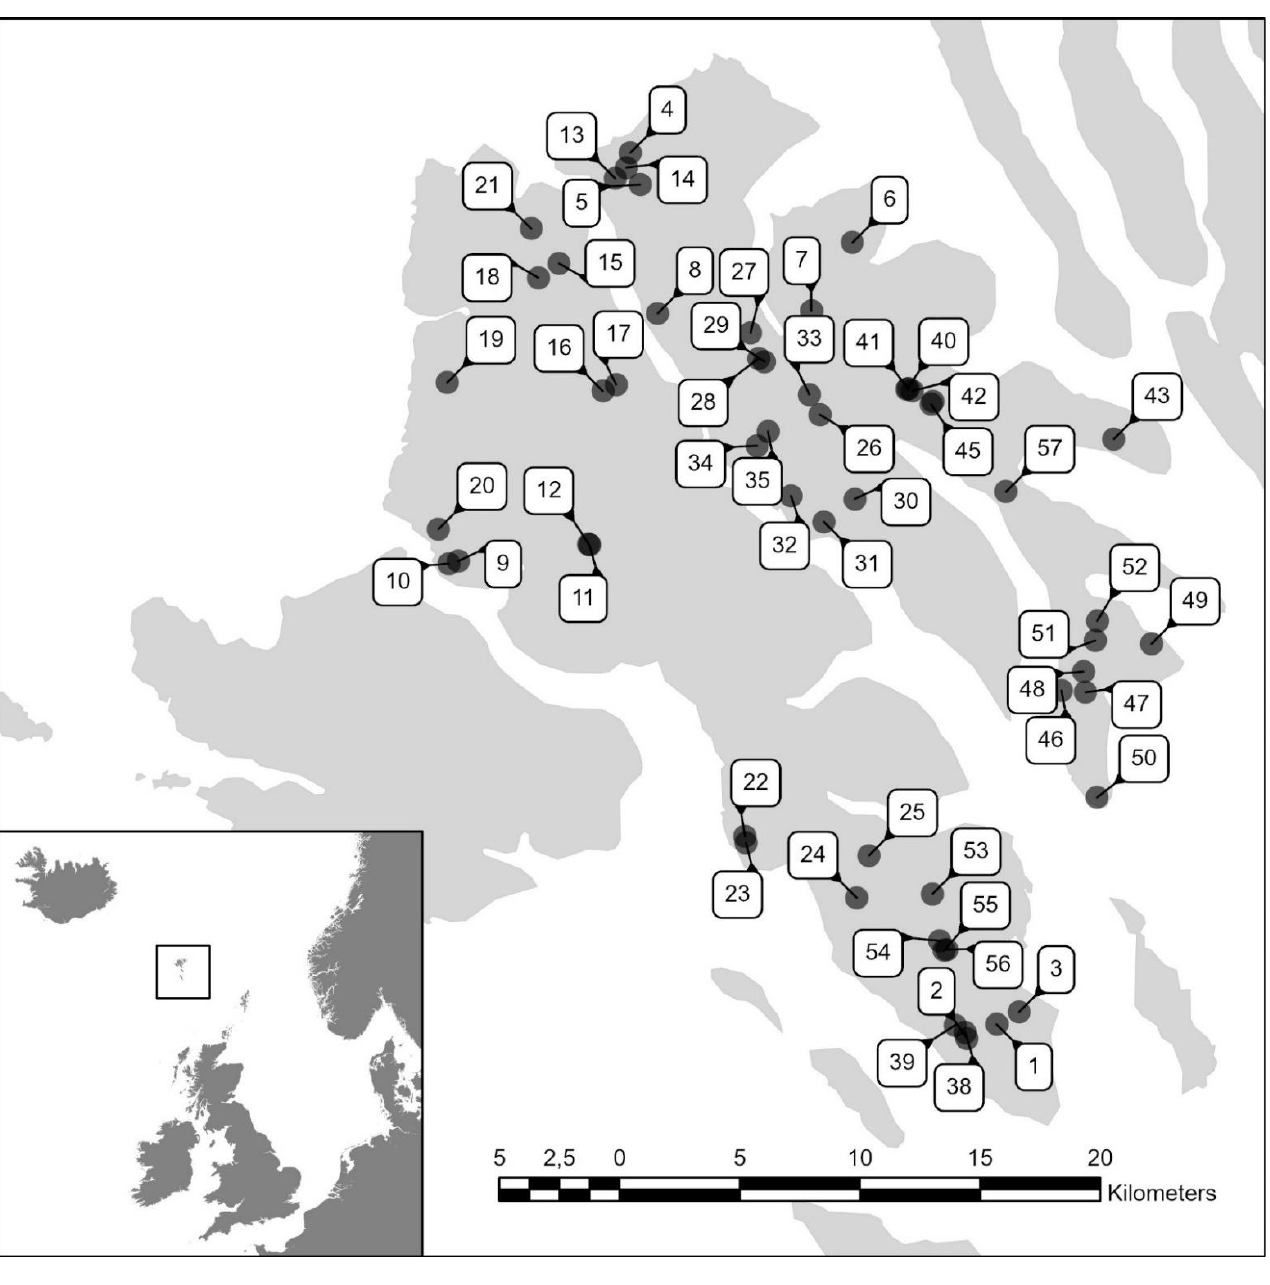
Figure 1. Map of the 57 sampled ponds on the islands Streymoy and Eysturoy. The numbers refer to ponds, as listed in Table 1. The figure inset shows the location of the Faroe Islands in the North Atlantic between Iceland, the British Isles, and Norway.